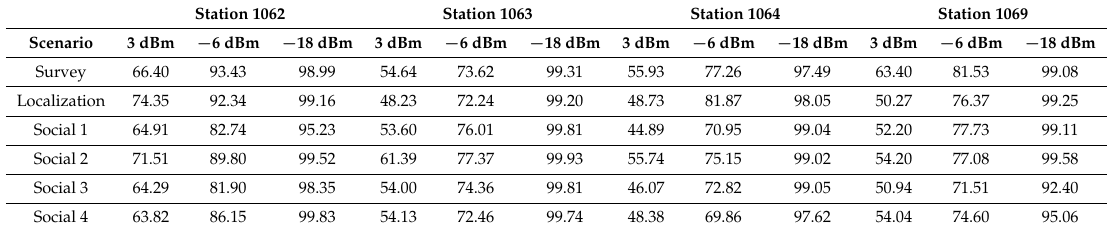
Table 6. Packet loss rate experimented by Anchors 1062, 1063, 1064 and 1069.